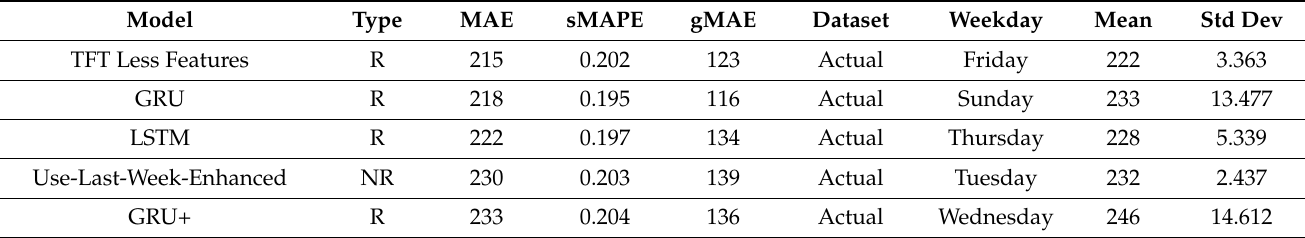
Figure 15. Kernel Ridge Daily Differenced One-Day Forecast. MAE of 214, sMAPE of 19.6%, and gMAE of 126, with 72 features. Original predictions ( top ) and the transformed back version ( bottom ) are both shown. This shows the best performing one-day forecast. Table 4. Top 25 One-Week Forecast Results. We show the top 25 results for one-week forecasting from all tests, sorted by dataset, then ranked from best to worst. The model, test MAE, sMAPE, gMAPE, and the dataset used to achieve the result are given. One-week specific metrics such as best start day, the mean of each weekday start, and the standard deviation between each start are also included. Best results are bolded. RNN models with the Actual dataset are the only results to beat the baseline Use-Last-Week-Enhanced. Alternate methodologies for extending non-RNN models to longer horizon windows must be explored further and sorted by MAE then